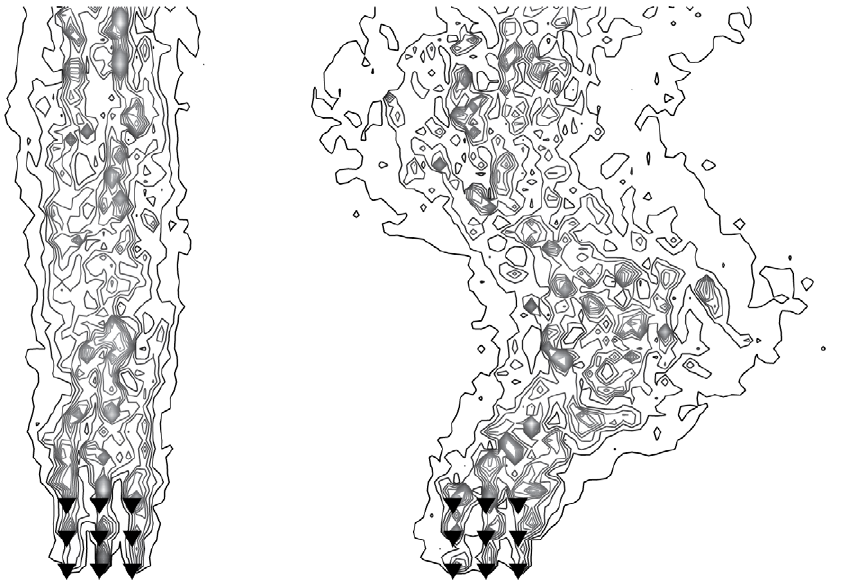
Figure 5. Examples of straight and meandering plumes with a superposed random velocity field. The triangles denote host position. The contours show concentration level, with darker bars indicating lower concentration. The lowest contour is C 0 and is the same in both plots. The other contours are not the same in both plots because the maximum concentration is roughly three times higher in the meandering plume. doi:10.1371/journal.pcbi.1002500.g005 PLoS Computational Biology |